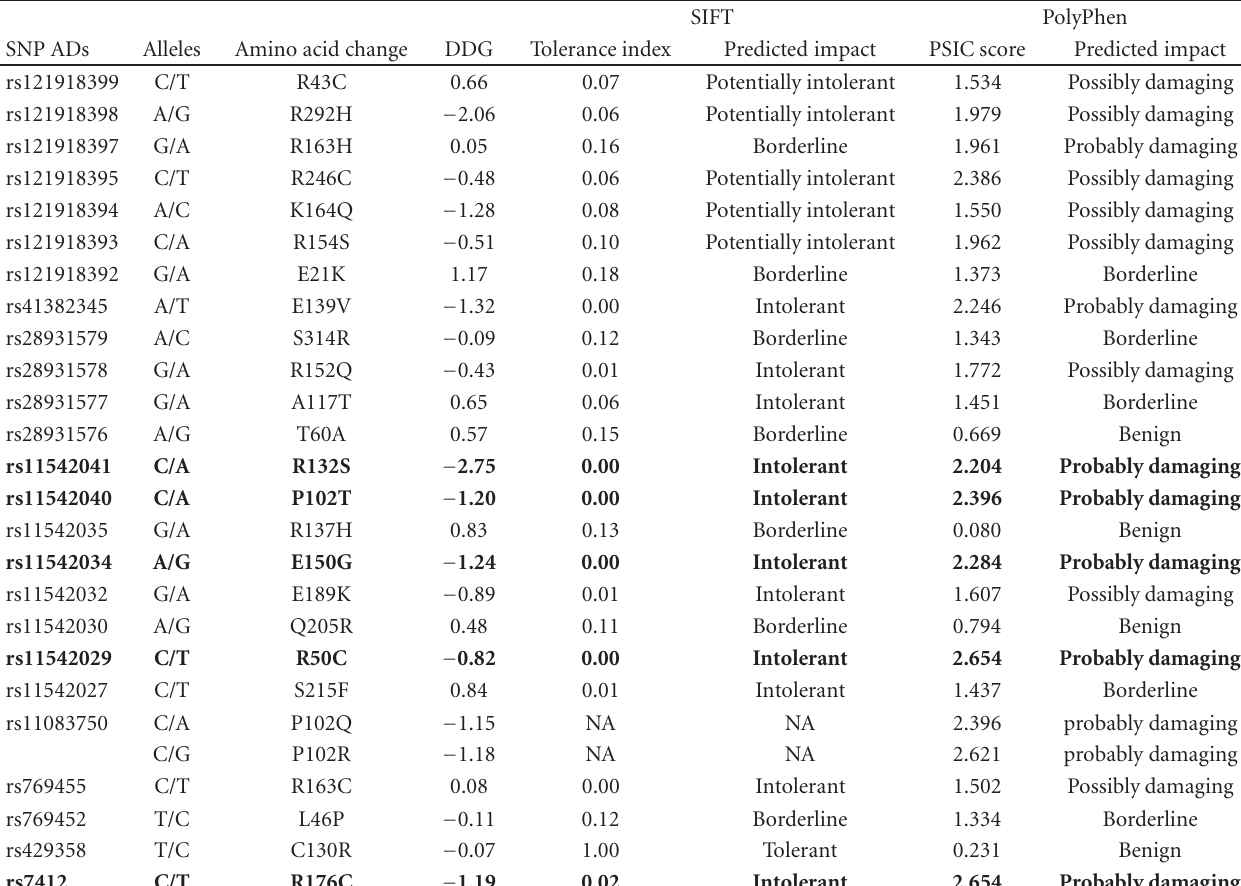
Table 1: I-Mutant, SIFT and PolyPhen results of